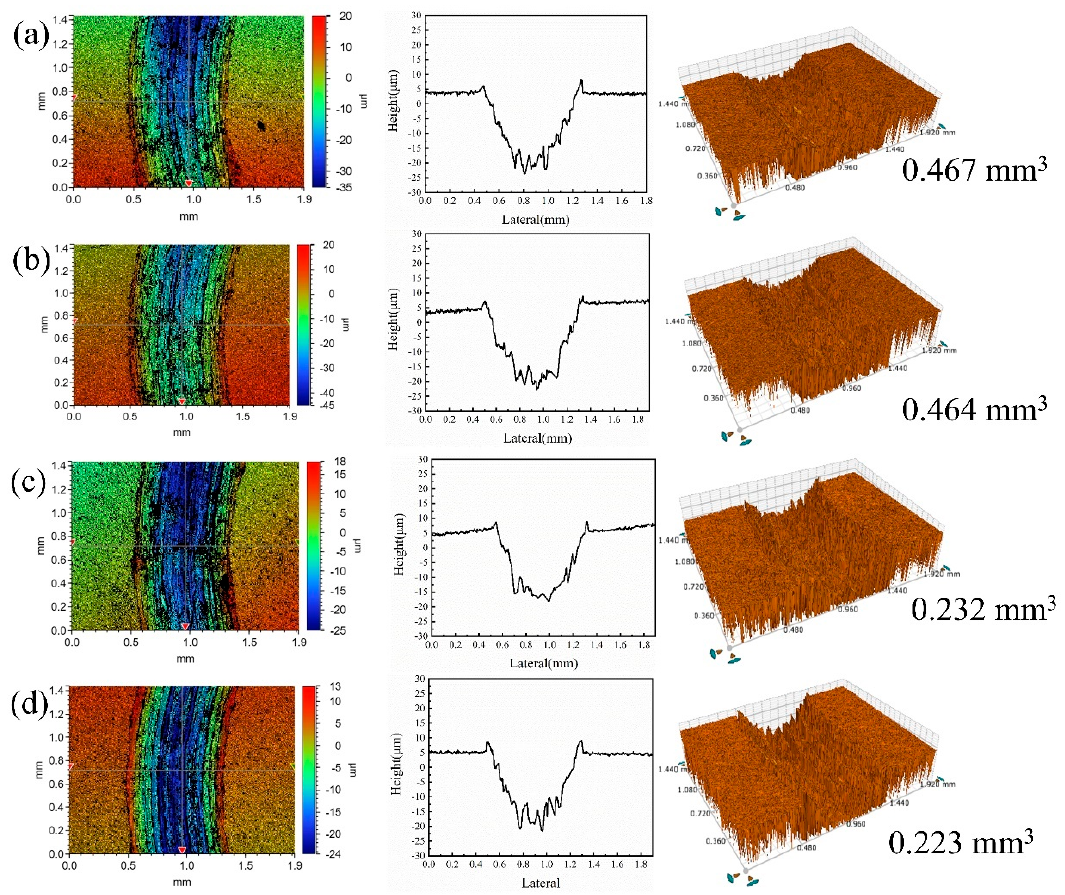
Figure 10. 3D depth maps of the wear scars on the discs lubricated by ( a ) ultrapure water ( b ) 075 wt.% L-BP, ( c ) 0.075 wt.% M-BP, and ( d ) 0.075 wt.% BPQDs (10 N, 150 r/min).